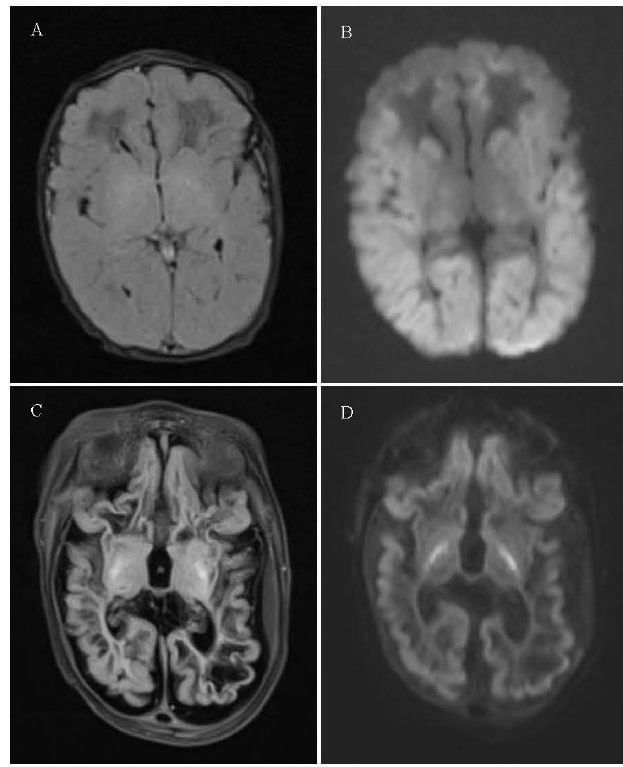
Figure 1. MRI scans. A-B: Axial cuts of the MRI of the brain obtained on DOL 8. A = T2 flair, B = diffusion-weighted sequence. Images show diffusely abnormal signal in the periventricular white matter of both cerebral hemispheres. There is also increased signal in the temporal and parietal cortex. C-D: Corresponding images of a repeat MRI of the brain at 6 weeks of life with severe global volume loss, cystic encephalomalacia and bilateral moderate subdural